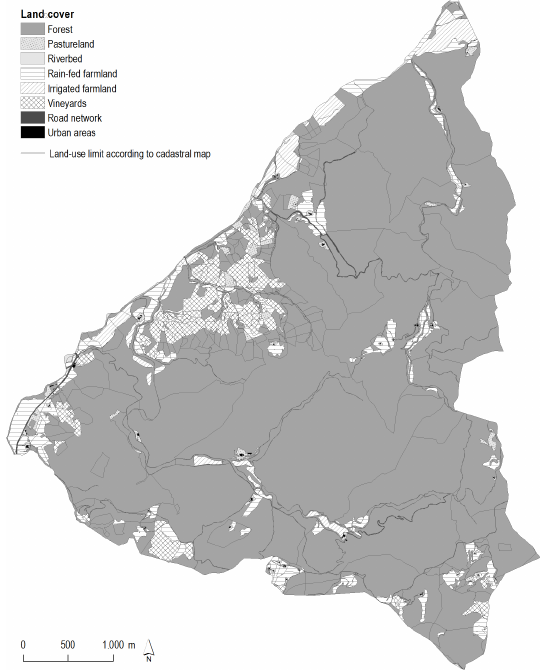
Fig. 4 . Land-cover map of Olzinelles (1950).